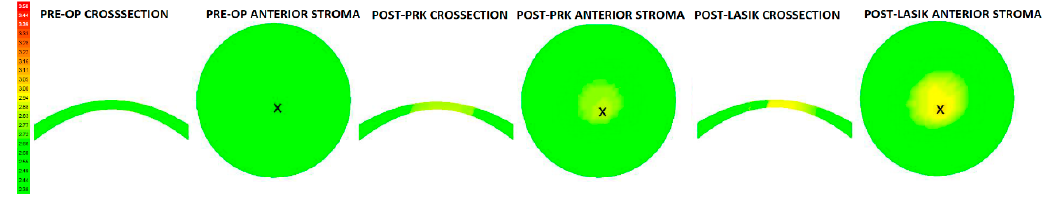
Figure 4. Example of maximum principal strain (MPS) maps for full-thickness vertical cross-sections and en face anterior stromal regions for pre-operative, post-PRK, and post-LASIK simulations, respectively. Strain maxima are indicated by an ‘x’ on the map. Higher MPS values were incurred in LASIK than in PRK in all cases.